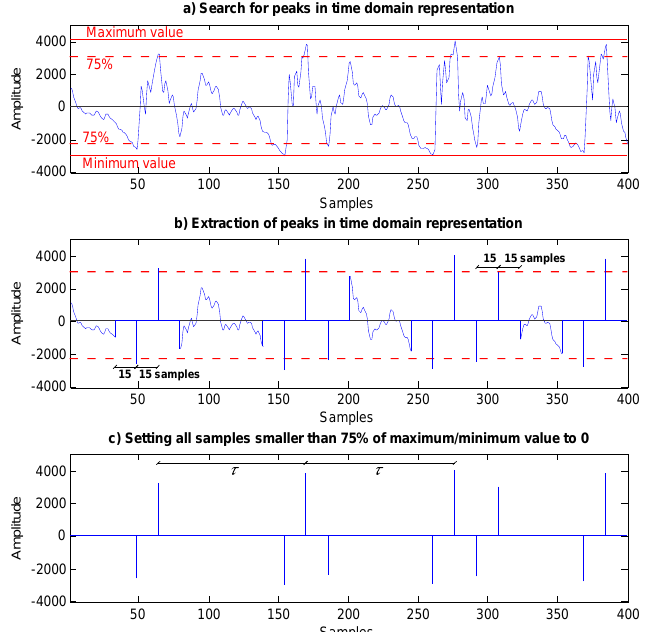
Figure 3. The time domain representation of the 65th frame in the digit sequence “seven six one three”: ( a ) Search for peaks in one speech signal frame. ( b ) Extraction of peaks, where 15 samples left and right of the peak are set to 0. ( c ) All samples smaller than 75% of maximum/minimum value are set to 0.